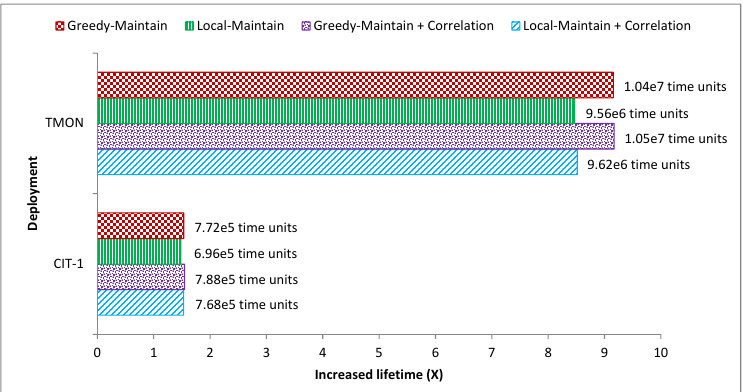
Figure 16. Increased lifetime for TMON and CIT-1 deployments using real energy storage in AA